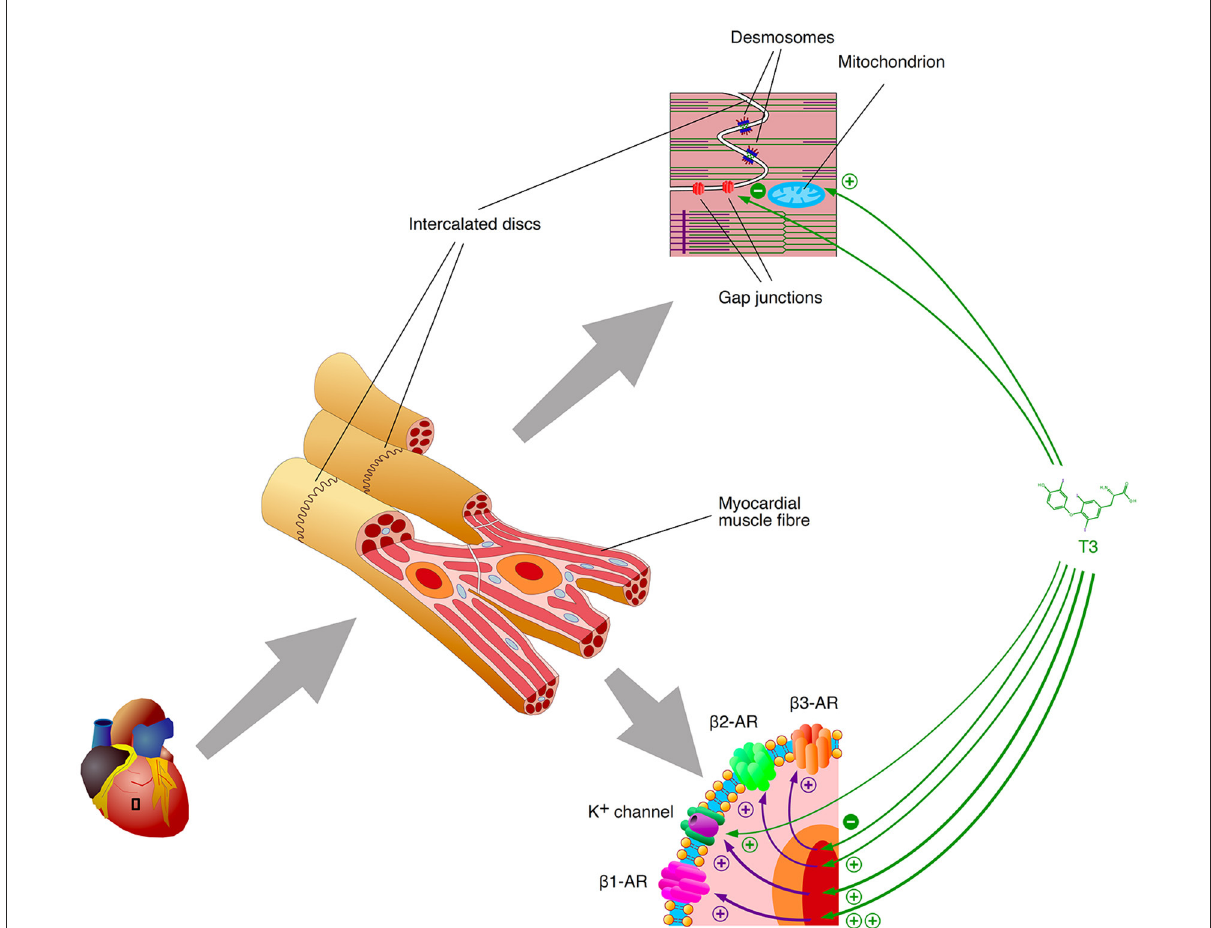
FIGURE3 Selected mechanisms of arrhythmogenesis by thyroid hormones. T3 (and other active thyroid hormones) upregulate the gene expression of beta1 and beta2 adrenoceptors via classical genomic signaling, but downregulate protective beta3 adrenoceptor expression. The transcription of critical genes for the formation of gap junctions is downregulated as well. Potassium channels are regulated via classical type 1 signaling and via non-genomic effects (type 4 action) as well. Purple arrows indicate the effects of gene expression (transcription, translation and associated processing steps), green arrows visualize the impact of T3-agonistic thyroid